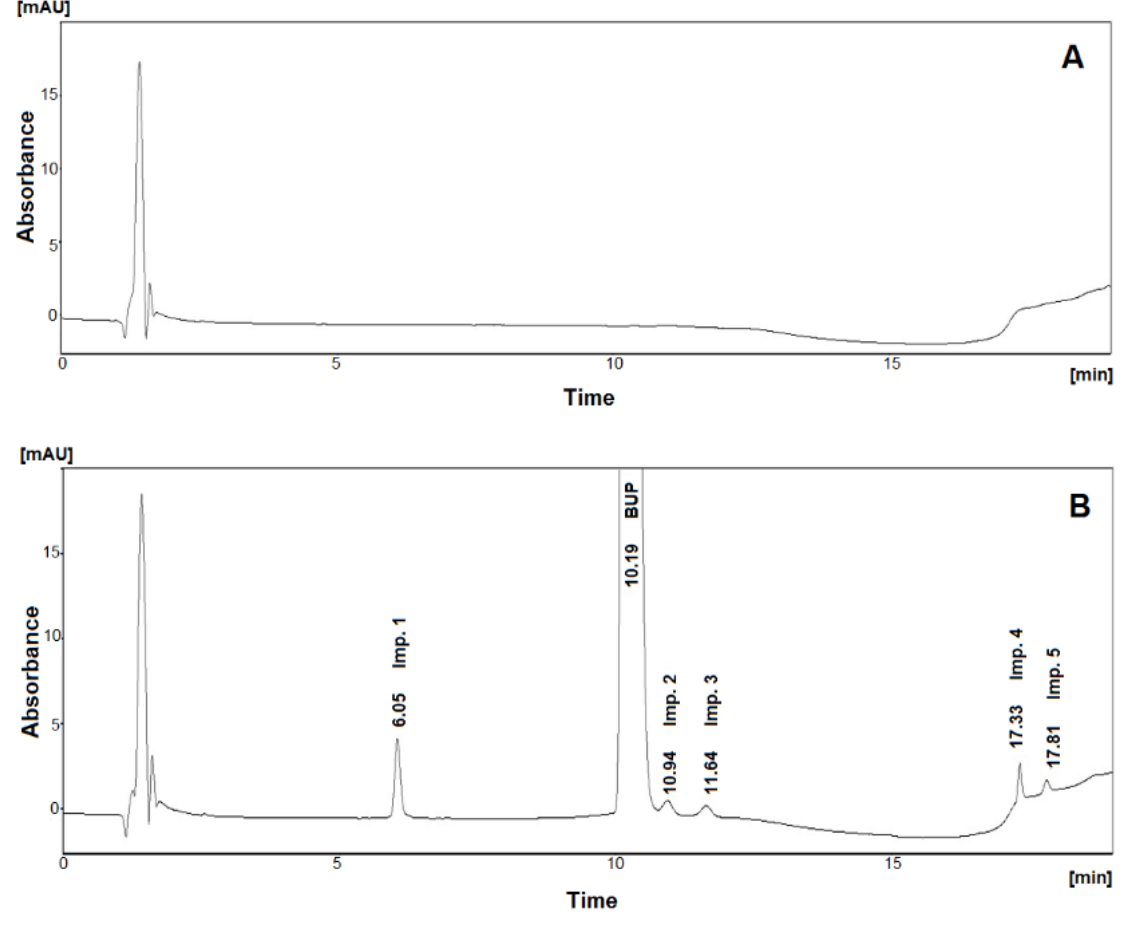
Figure 4. Chromatograms obtained under conditions suggested by the working point: ( A ) placebo mixture of excipients, ( B ) sample solution containing 400 μg/mL BUP spiked with all impurities at their SL.